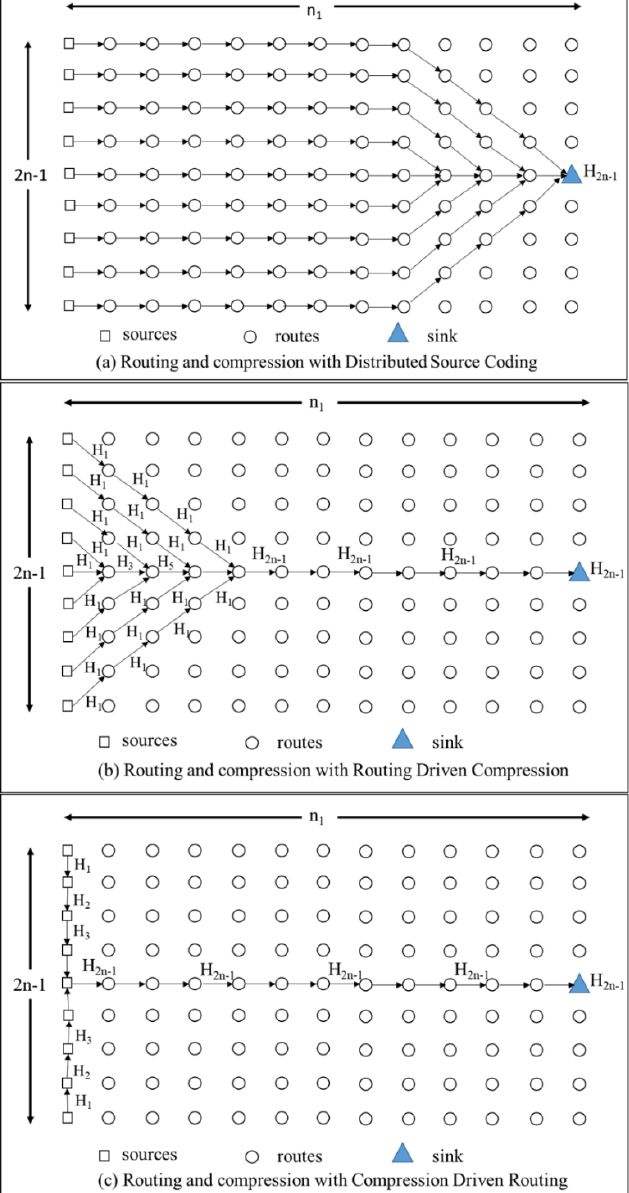
Figure 7. Routing paths for three schemes: ( a ) DSC, ( b ) RDC, and ( c ) CDR in Reference [17].